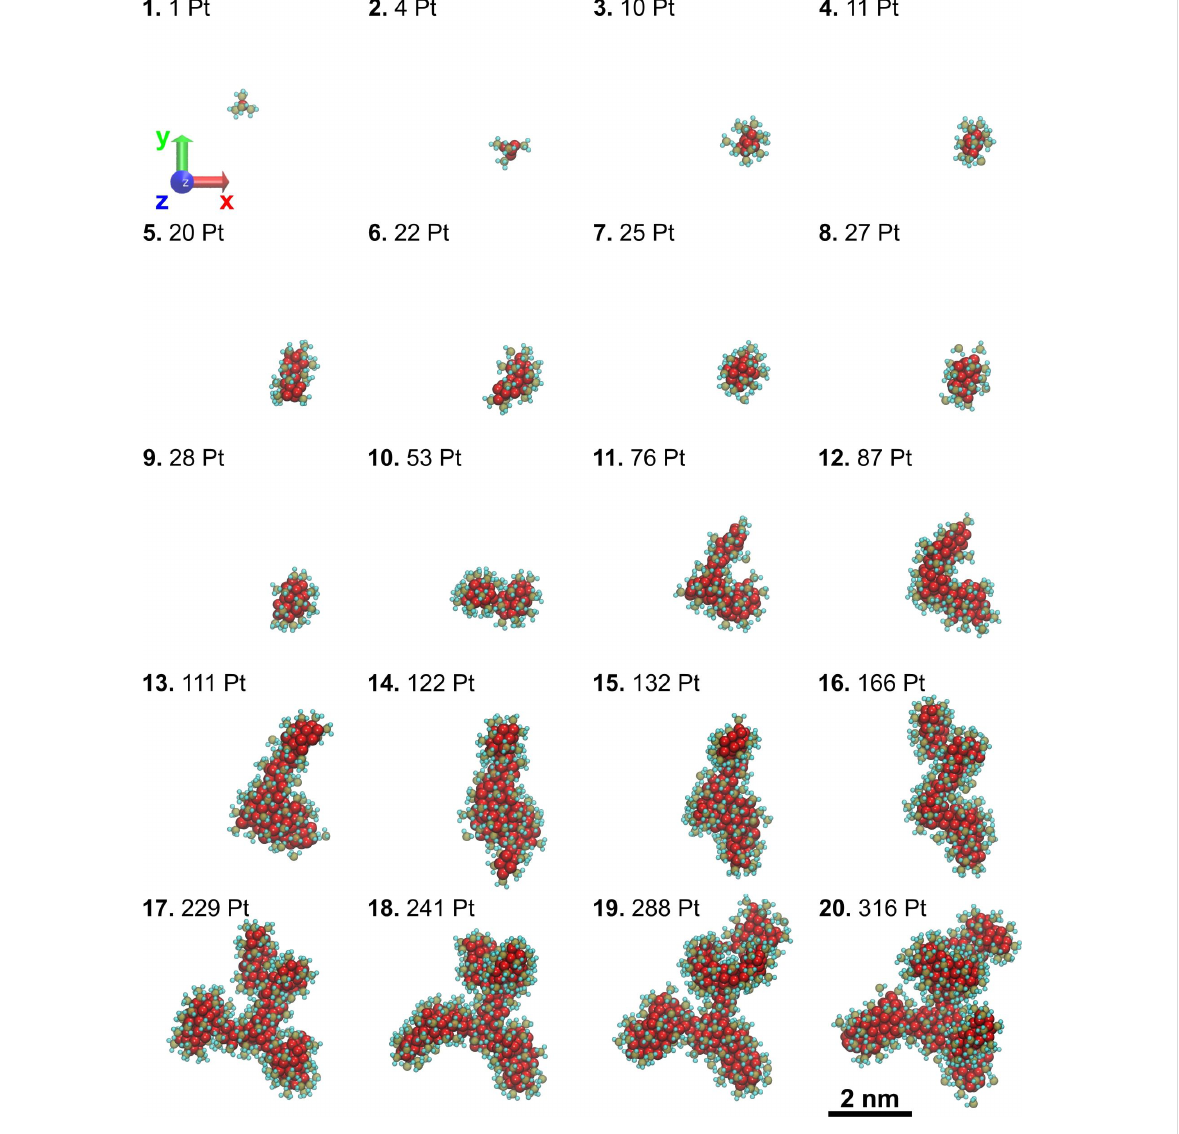
Figure 7: Evolution of the largest cluster in the course of simulation at the end of each FEBID simulation cycle (shown in bold). The number of Pt atoms is also indicated for each structure.